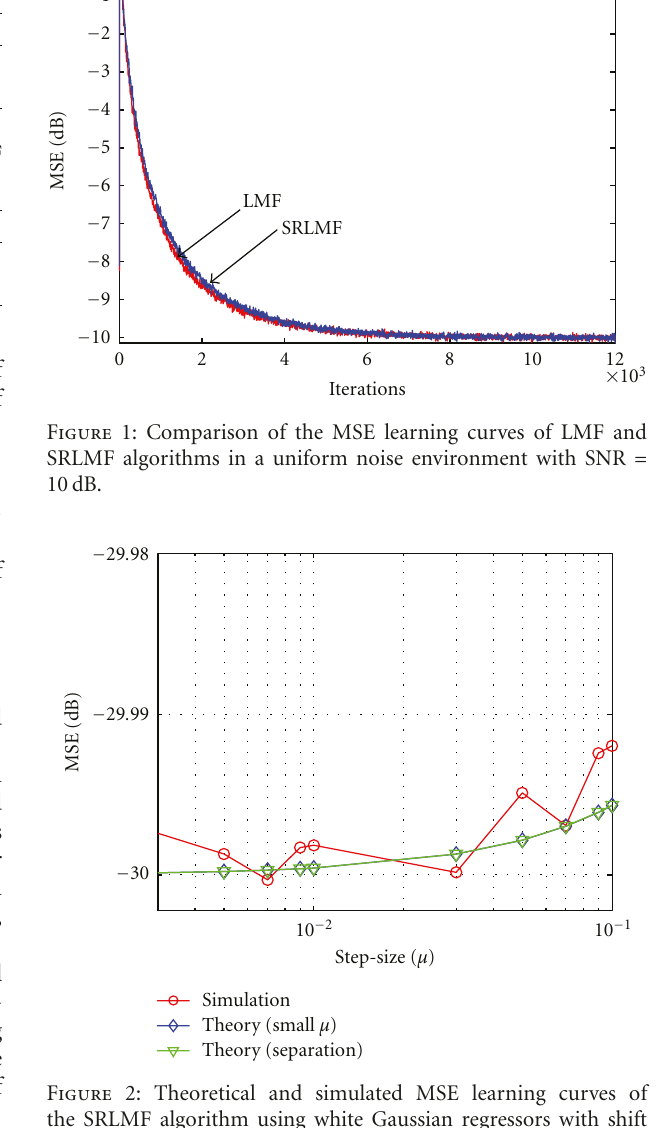
Table 1: Computational load per iteration for LMF and SRLMF algorithms when data is real.